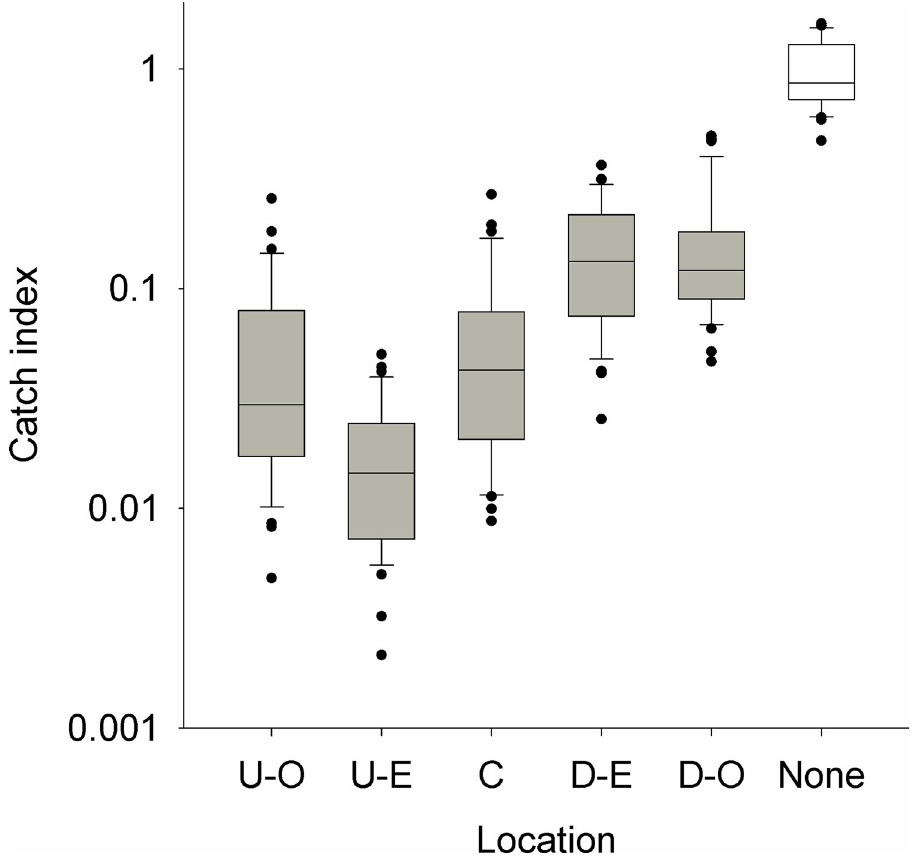
on the upstream edge (U-E), centre (C), or downstream edge (D-E) or downstream and outside (D-O). Catch Indices are the mean daily catch per month at each location (Fig 2) for the period January 2012-October 2014, when targets were deployed, expressed as a proportion of the mean catch for September-October 2011 before targets were